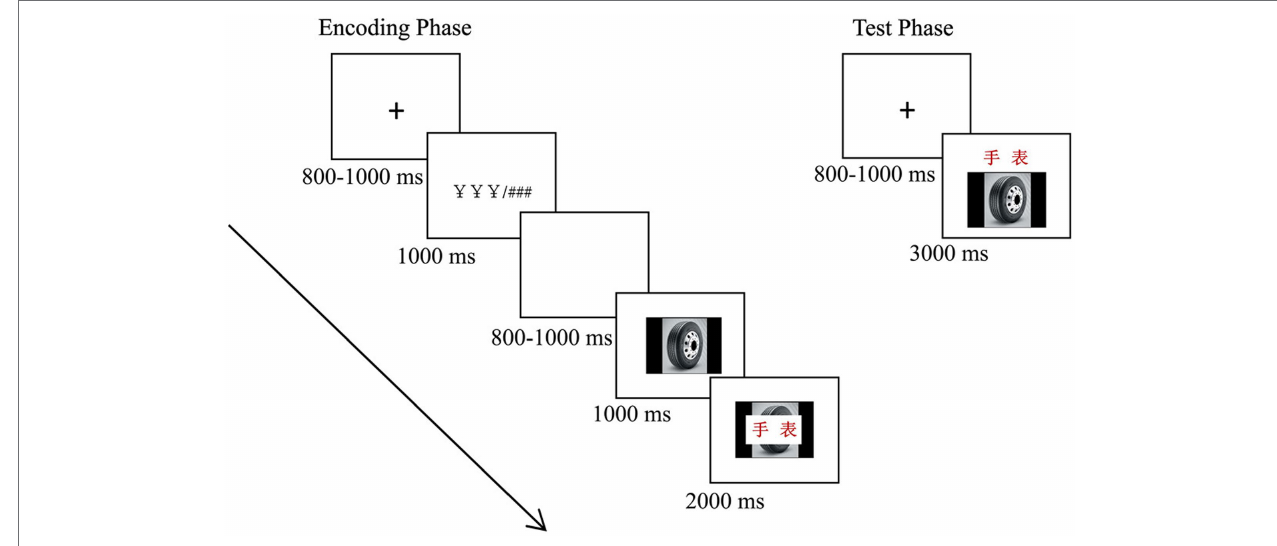
FIGURE 1 | Schematic representations of a trial in the encoding phase (left) and test phase (right). See the text for details, and “ 手表 ” in the figure means